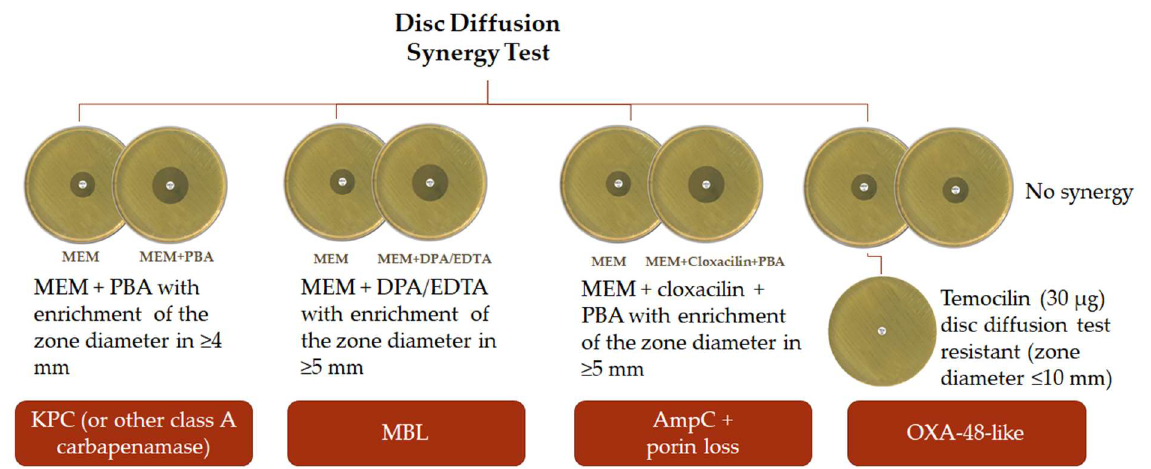
Figure 1. Interpretation of phenyl boronic acid (PBA), dipicolinic acid (DPA), and cloxacillin synergy tests and temocillin disc diffusion in comparation with meropenem (MEM) disc diffusion alone.